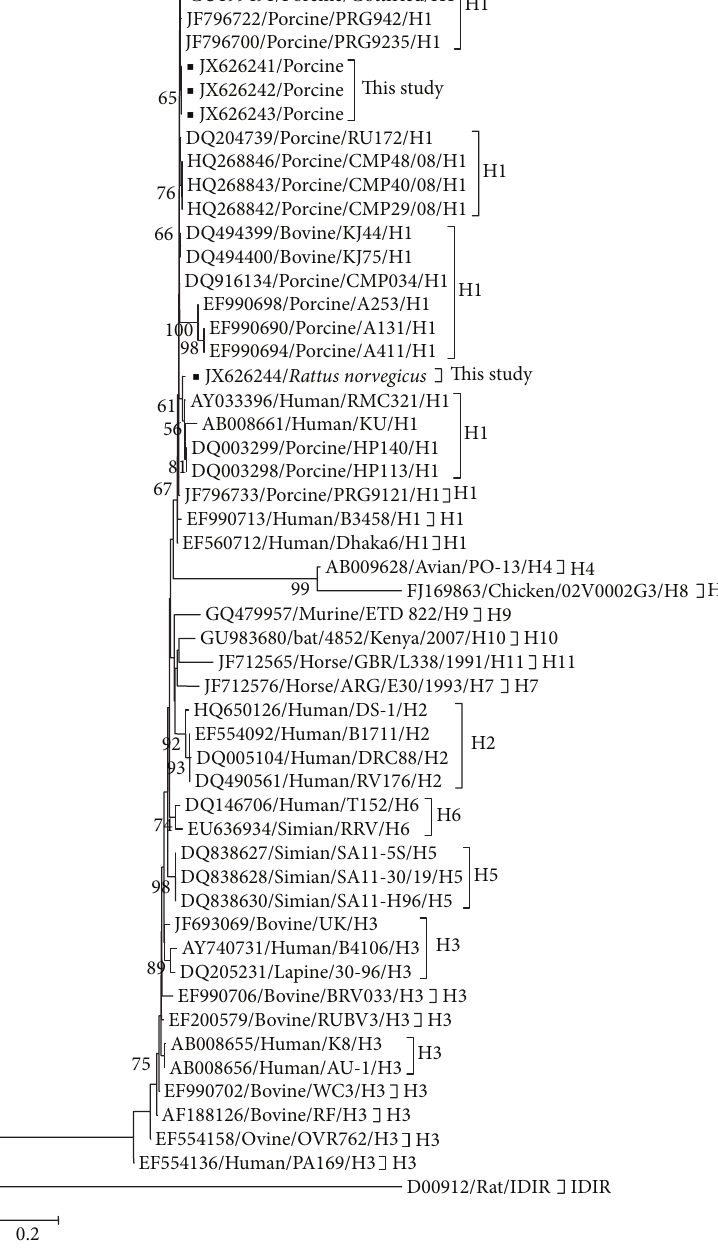
Figure 1: Nucleotide neighbor-joining distance tree (maximum composite likelihood model) for the partial NSP5 rotavirus gene showing the known genotypes for this gene. Pig and rat strains in the present study are preceded by black squares. The numbers at each node are bootstrap values (1,000 replicates). The bar represents the number of substitutions per